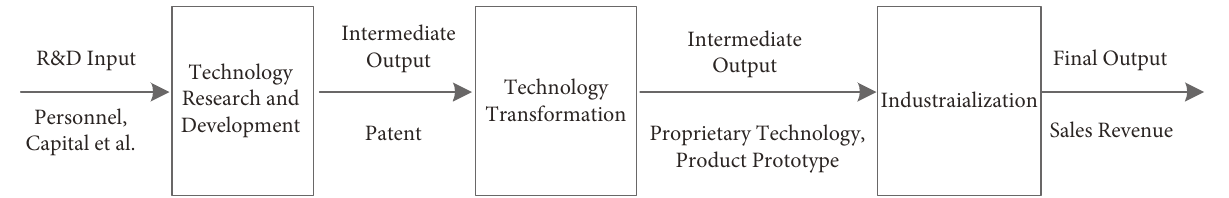
Figure 1: The three-stage technological innovation process of the high-tech industry. Table 1: Indicator system of technology research and development